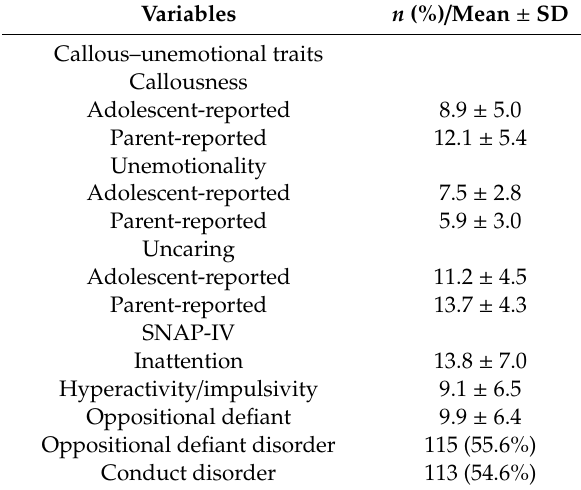
Table 1. Levels of callous–unemotional traits, attention-deficit / hyperactivity disorder (ADHD) and oppositional defiant symptoms, and psychiatric comorbidities ( n = 207).